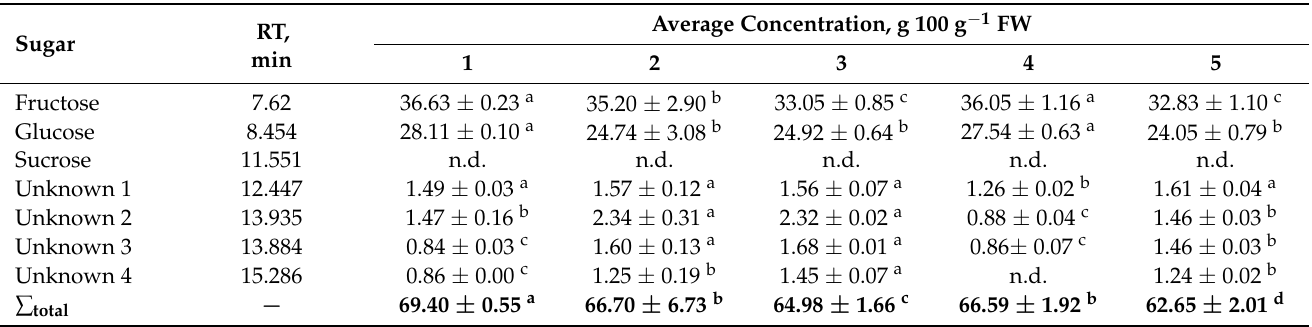
Table 4. The concentration of individual sugars in selected honey samples, g 100 − 1